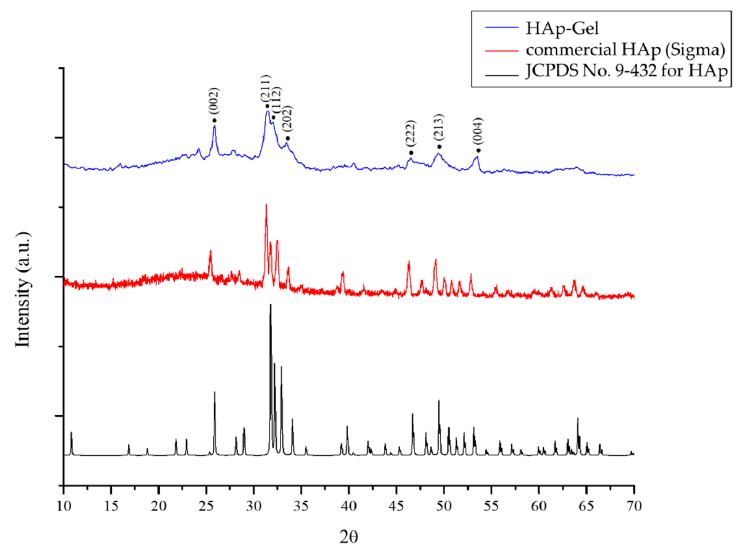
Figure 3. XRD patterns of the HAp–gelatin porous composite microspheres, the commercial HAp, and JCPDS file No. 9-432 for HAp.